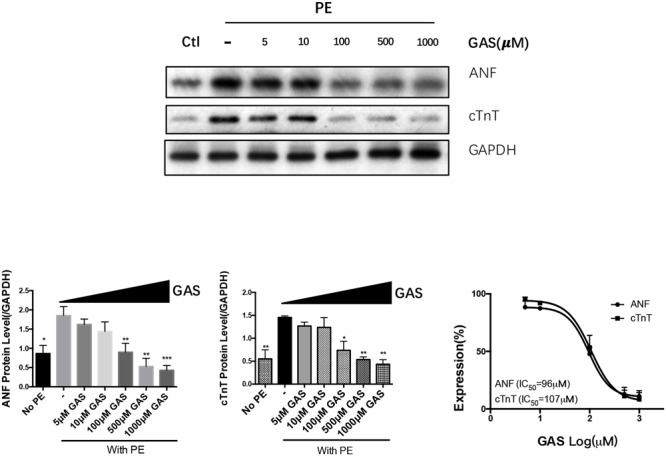
Dose-dependent inhibition of gastrodin on phenylephrine-induced hypertrophy of NRCMs. NRCMs were treated with 50 μmol/L PE for 48 h to induce hypertrophy. GAS (0–1000 μmol/L) was applied 12 h before PE. The control group (no PE) did not undergo PE treatment. Effect of gastrodin on the expression of ANF and cTnT was demonstrated. Shown were representative immunoblot images (upper panel), data summary (lower panels) and determination of IC50 values (lower right). The data are expressed as the mean ± SEM (n = 5). ∗p < 0.05, ∗∗p < 0.01, ∗∗∗p < 0.001.